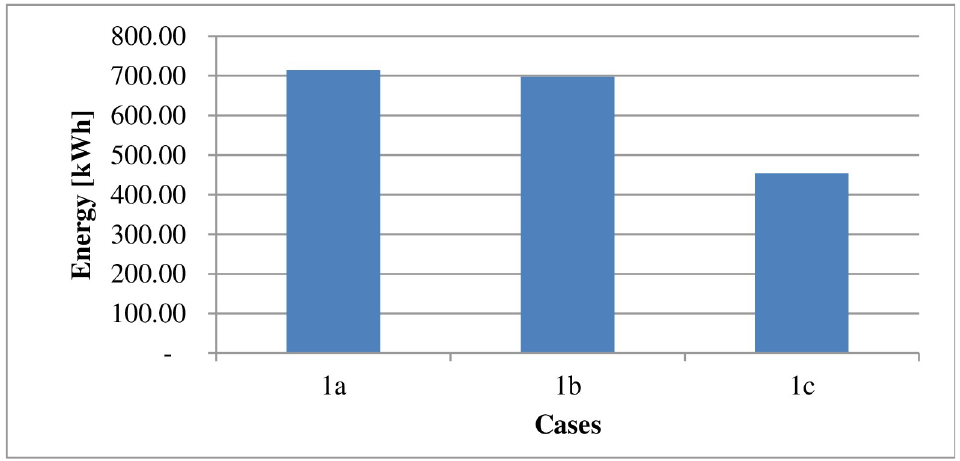
Fig 2. Energy losses per day–case